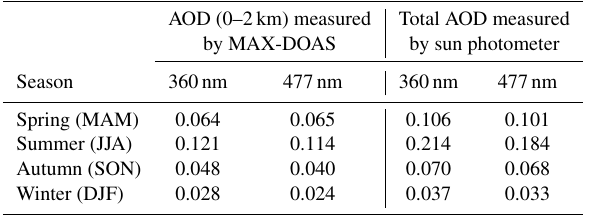
Table 7. Seasonally averaged AODs measured by the MAX-DOAS and sun photometer at the UFS. The AODs measured by the MAX- DOAS refer to the AODs between 0 and 2km above the instru- ment (i.e., 2650–4650ma.s.l.), and the measurements were avail- able during the daytime with SZA < 85 ◦ and no cloud; the AODs measured by sun photometer refer to the total AOD, and the mea- surements were only available during 10:00–14:00UTC. The re- sults listed in the table are calculated from all the available hourly averaged AODs. AOD (0–2km) measured Total AOD measured by